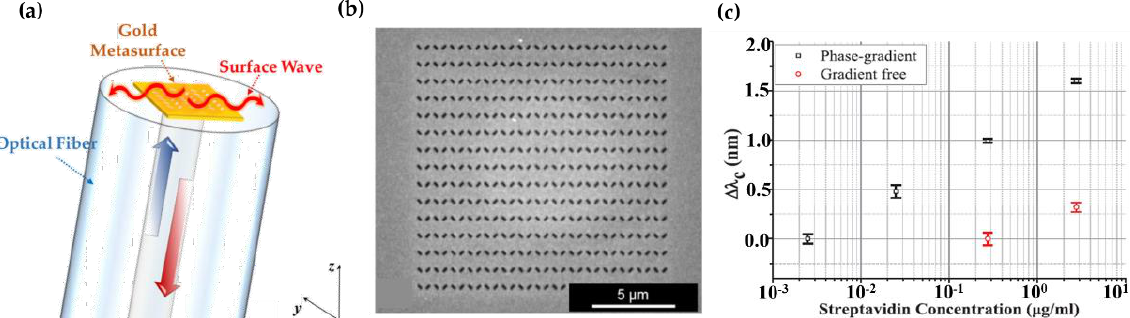
Figure 9. ( a ) Schematic of the fiber meta-tip for the excitation of the surface wave. ( b ) SEM image of the phase-gradient meta-tip. ( c ) Dose-response curves pertaining to the phase-gradient fiber meta-tip (black squares) and gradient-free benchmark (red circles) biosensing platforms. Reprinted with permission from Ref. [65]. Copyright 2020, Wiley-VCH.